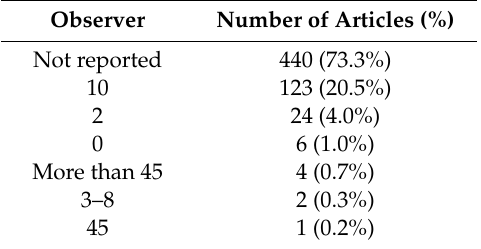
Table 6. Data for observer studied for measuring milk color.